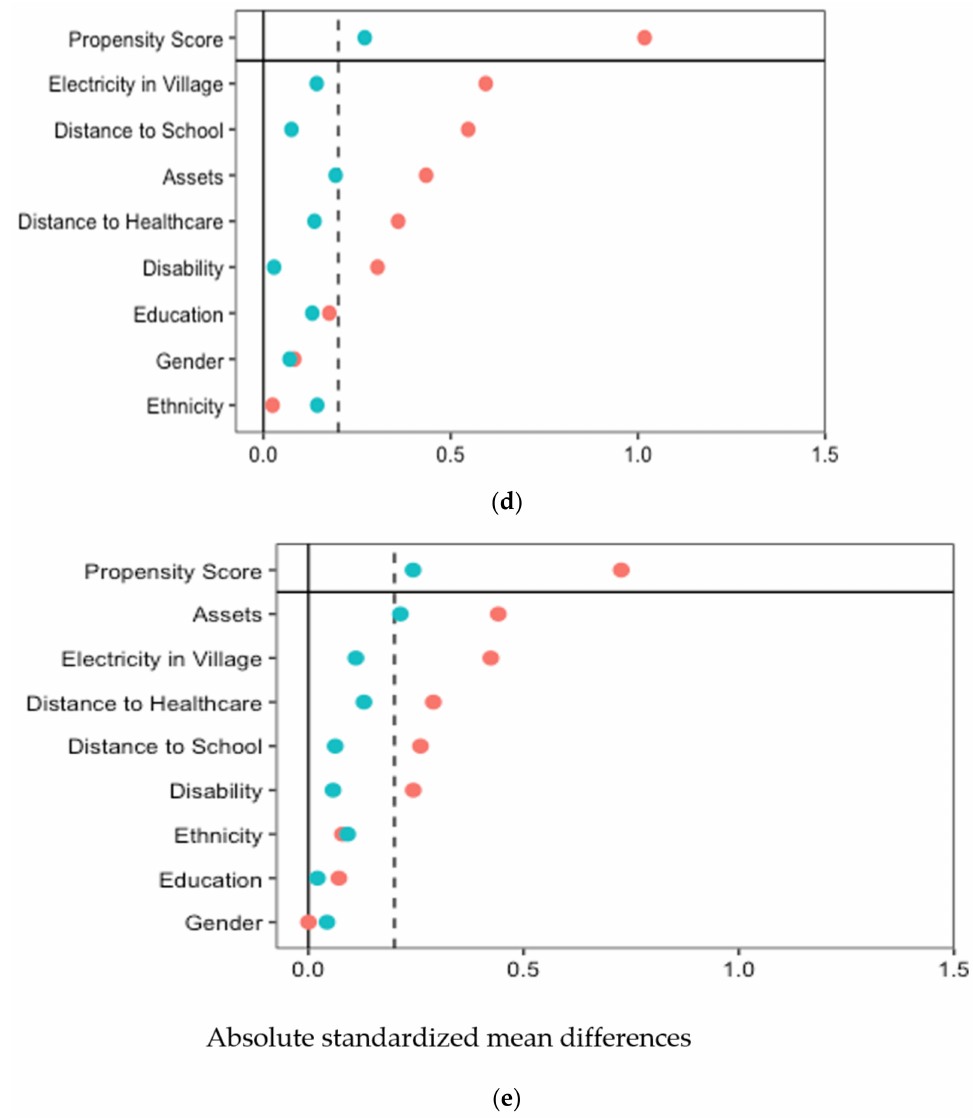
Figure 2. Balance results of the propensity-score matching for the sample for five models of access to services. Model 1: Physiotherapy, Model 2: Assistive devices, Model 3: Employment, Model 4. Education, and Model 5. Advocacy and community mobilization. ( a ) Model 1: Comparative access to physiotherapy; ( b ) Model 2: Comparative access to assistive devices; ( c ) Model 3: Comparative access to employment and livelihood support; ( d ) Model 4: Comparative access to education support; ( e ) Model 5: Comparative access to advocacy and community